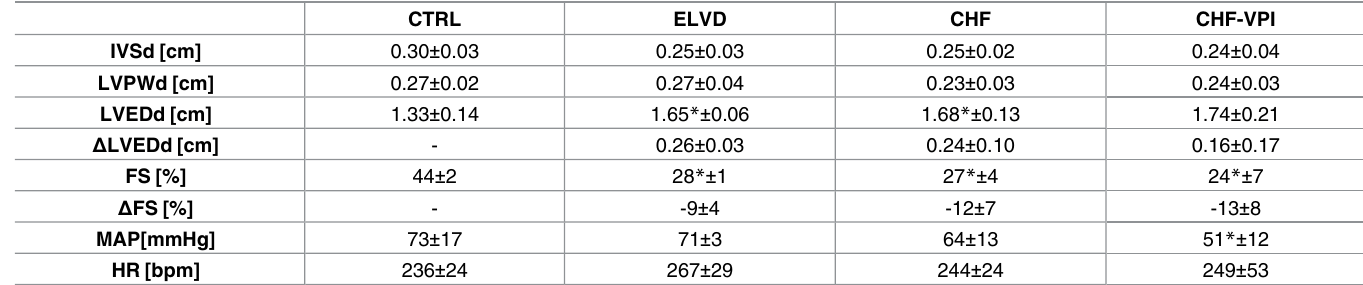
CTRL, control; ELVD, early left ventricular dysfunction; CHF, congestive heart failure without treatment; CHF-VPI, congestive heart failure with vasopeptidase inhibitor; IVSd, diastolic interventricular septum thickness; LVPWD, diastolic thickness of left ventricular posterior wall; LVEDd, left ventricular end-diastolic diameter; Δ LVEDd difference of left ventricular end-diastolic diameters within the same group (i.e., vs. baseline); FS, fractional shortening; Δ FS, difference of fractional shortening within the same group (i.e., vs. baseline); MAP, mean arterial pressure; HR, heart rate. * P < 0.05 vs. baseline values in each